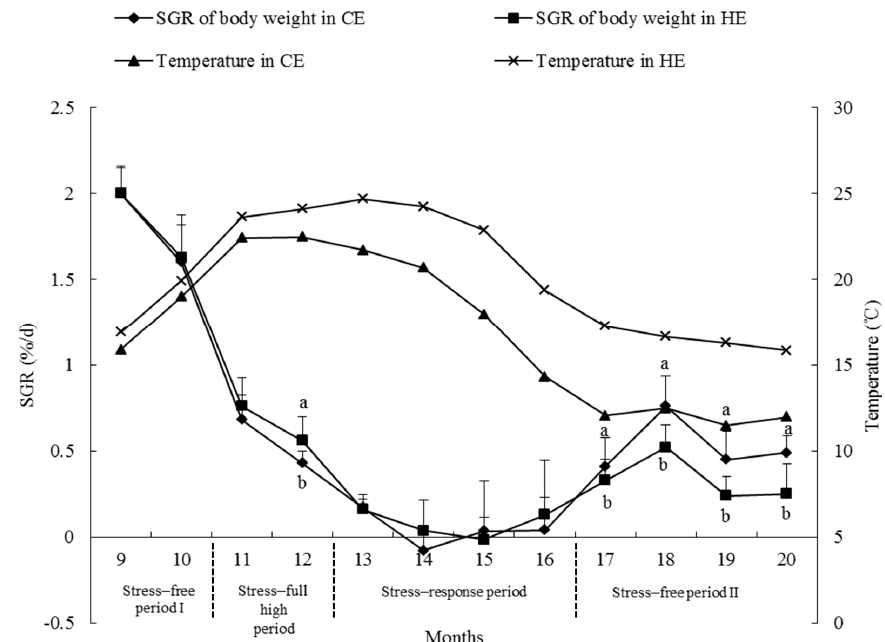
Figure 3. Comparison of specific growth rate of body weight between high temperature (HE) and control temperature (CE) environments. In each month, lower-case letters (a, b) indicate the difference between temperatures, different letters represent significant difference ( p < 0.05).